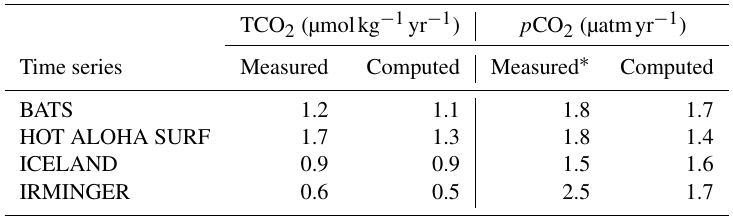
Table 5. Long-term trends (seasonally detrended) of the measured and computed TCO 2 and p CO 2 from neural networks at time series locations in the depth range 0–15m.